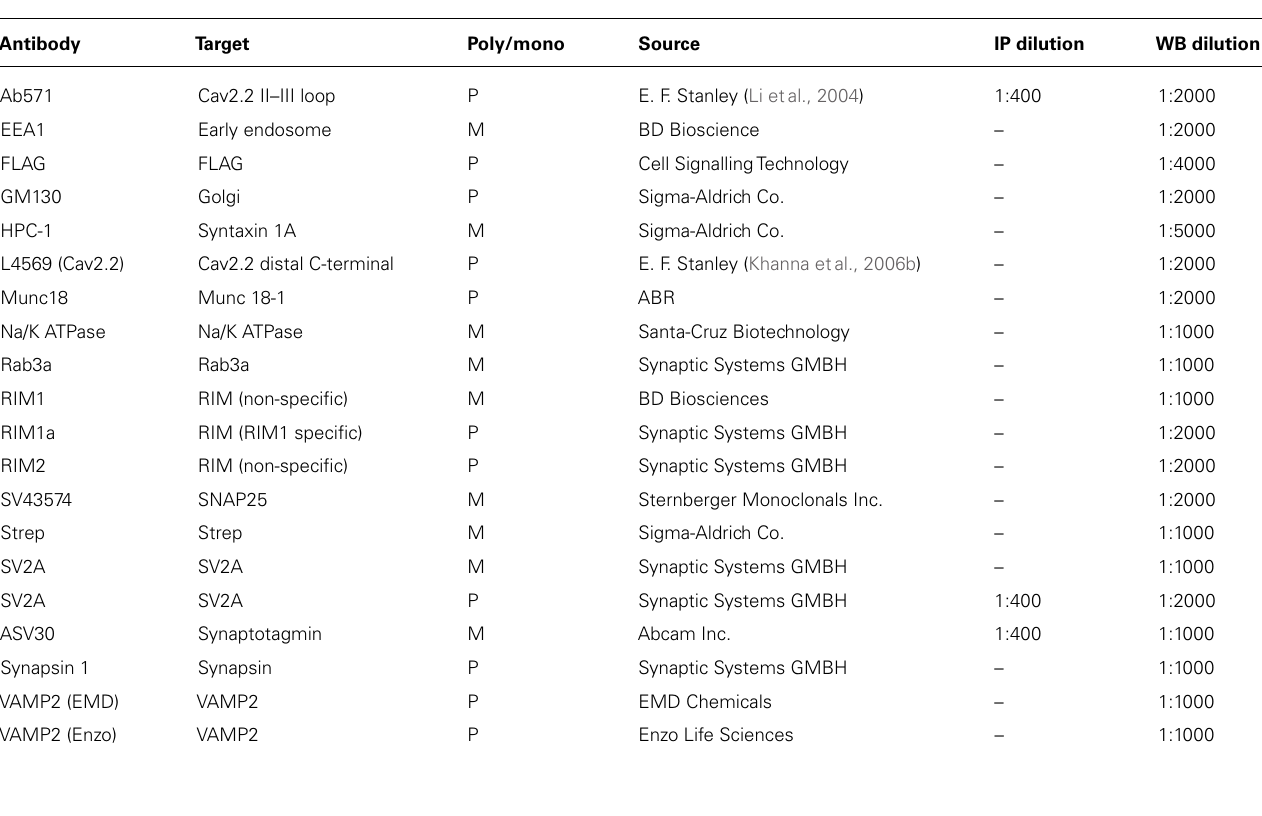
Table 1 |Antibodies used in this